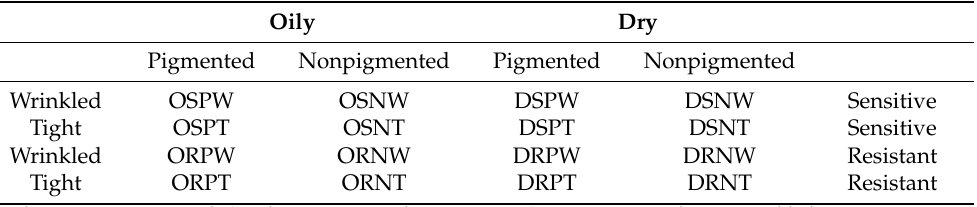
Table 1. The Baumann skin type system (BSTS)